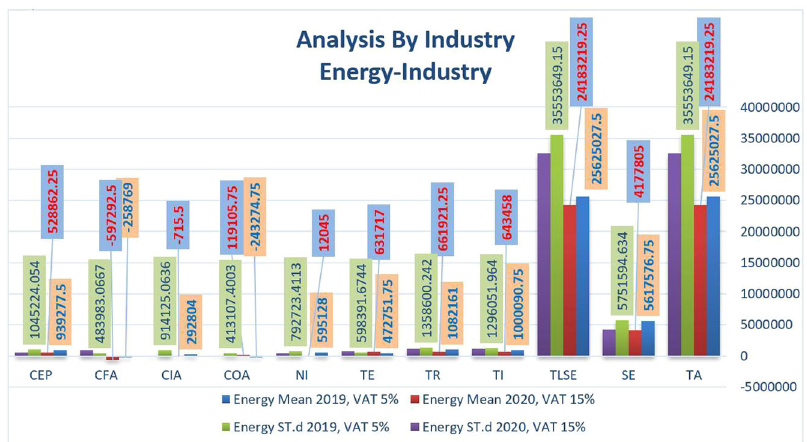
Fig. 3 Comparison of the fi nancial statements ’ key indicators in term of the average and standard deviation in Energy industry before and after rising VAT.